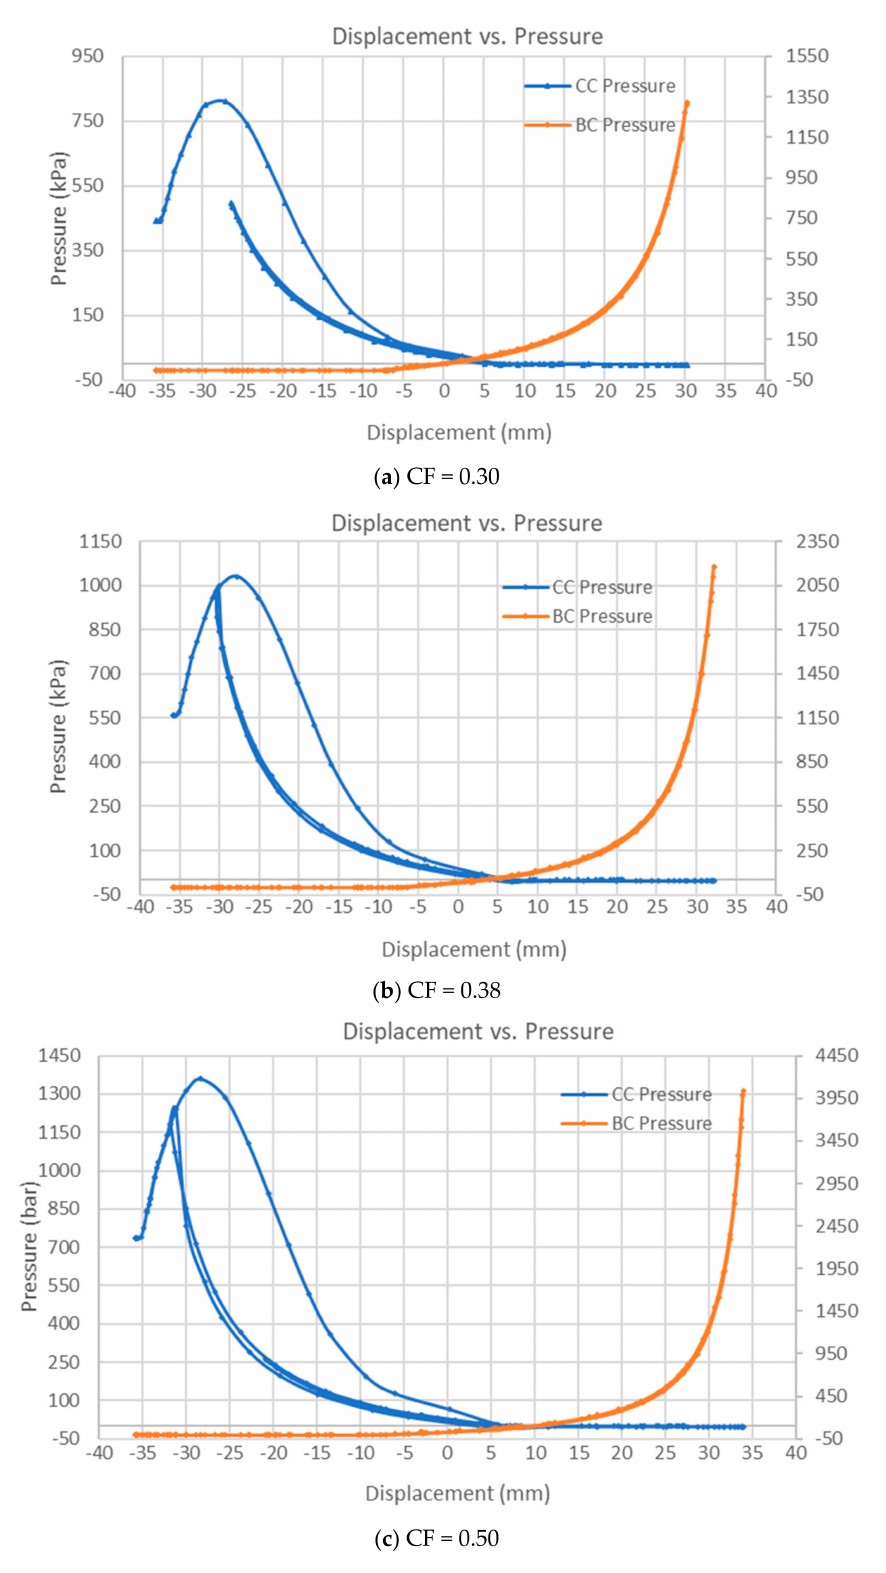
Figure 12. No-load operation with improved simulation model: pressure vs. displacement